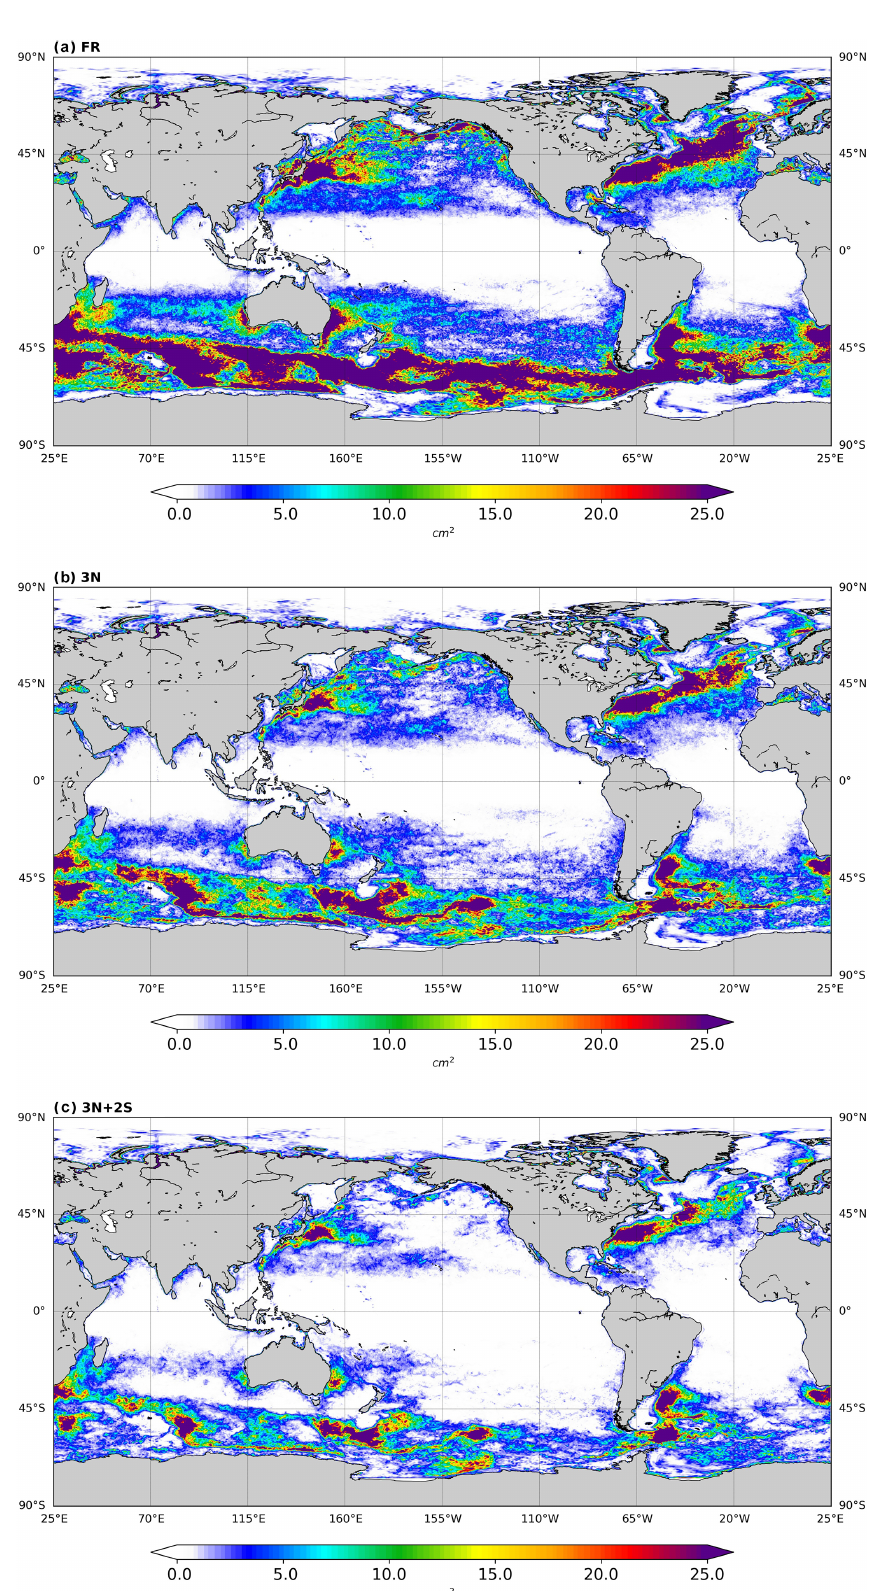
Figure 7. Global maps of SSH analysis error (NR – model analysis; wavelengths < 200km) variance (in cm 2 , 2015). (a) Free run (FR); (b) with three nadirs (3N); (c) with three nadir and two wide-swath instruments (3N + 2S). Ocean Sci., 18, 609–625, 2022